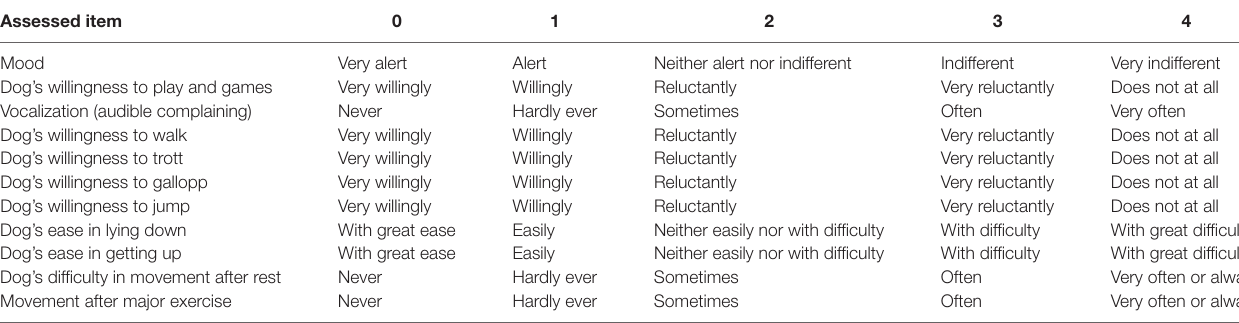
TaBle 2 | Pain assessment questionnaire including 11 questions with 5 answers (19).